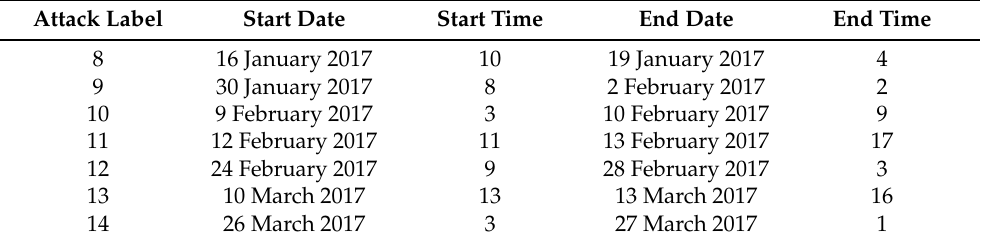
Table 2. Summarized results for the test data sets presenting start and end time date for each attack Attack